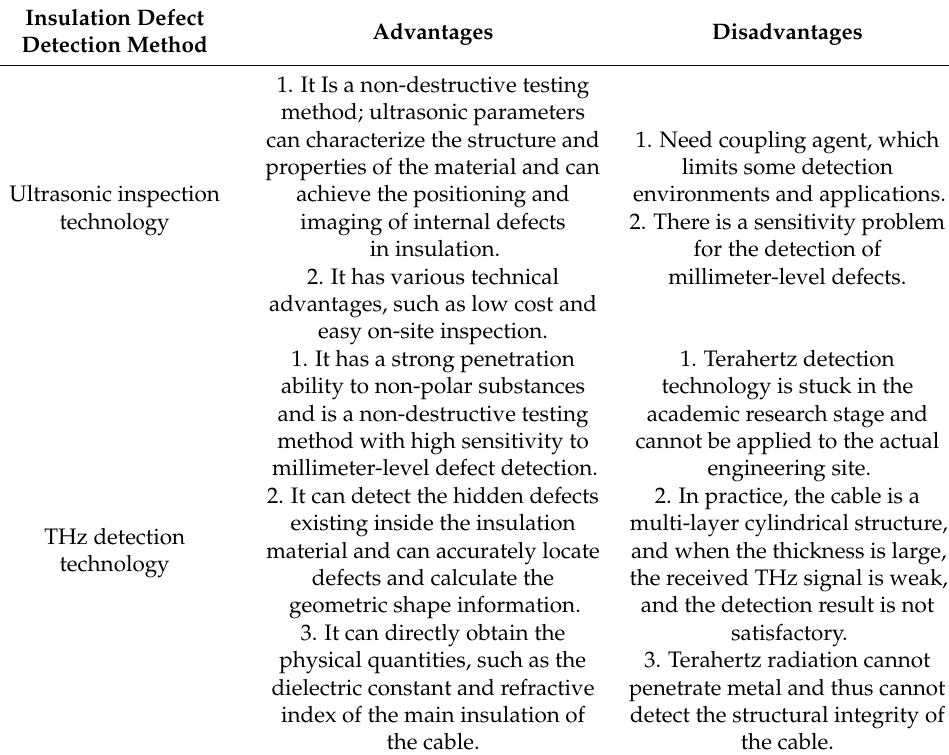
Table 2. Technical characteristics of cable insulation defect